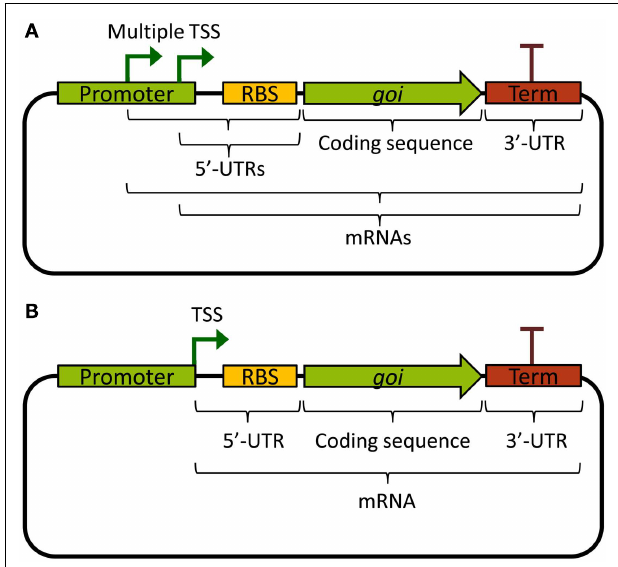
FIGURE 1 | Basic expression constructs differing in the promoters . (A) Example of a promoter with multipleTSS, producing multiple different mRNAs, and which contributes excess sequence to the 5 (cid:48) -UTRs. (B) Example of a well-defined standardized promoter that ends with itsTSS and hence does not contribute excess sequence to the 5 (cid:48) -UTR.TSS: transcriptional start site; UTR: untranslated region; RBS: ribosome binding site; goi: gene of interest;Term: transcriptional